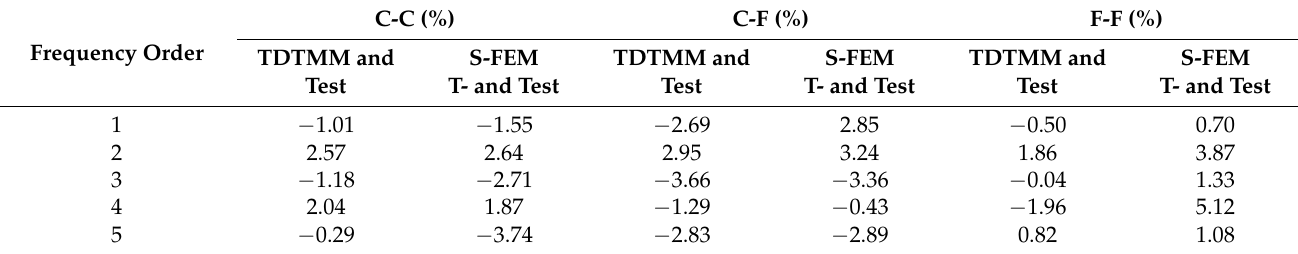
Table 10. The error of natural frequencies between TDTMM, S-FEM and test results of experimental